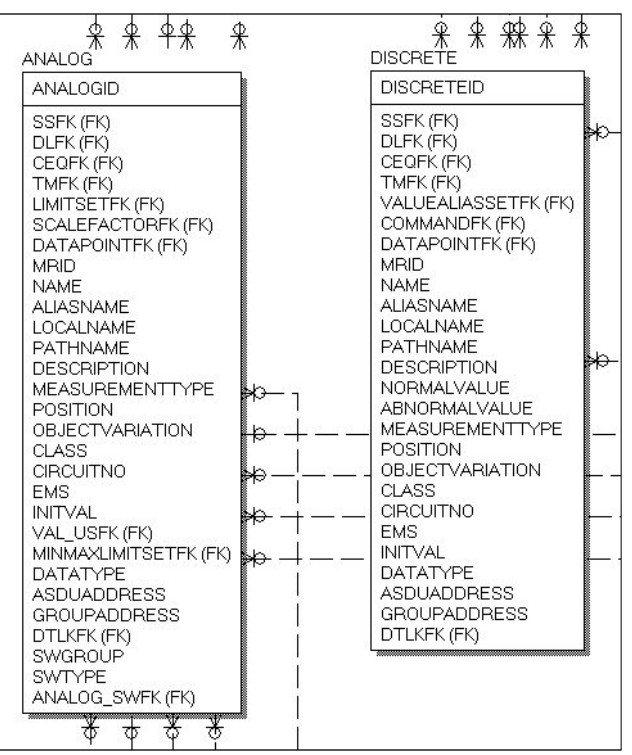
Figure 6. Analog and discrete tables of PDB.